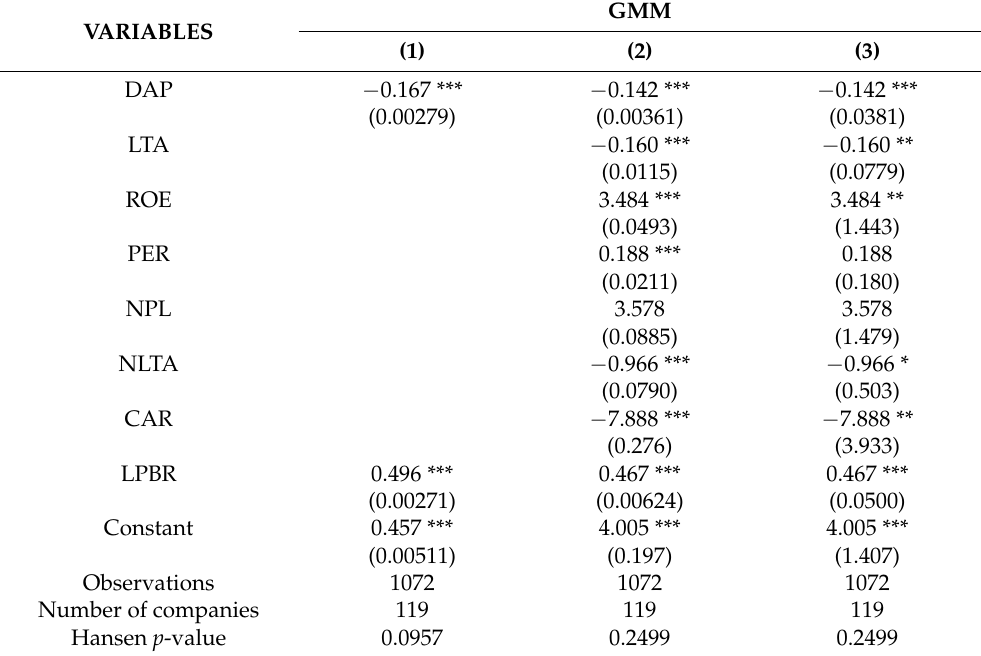
Table 4. Results of the